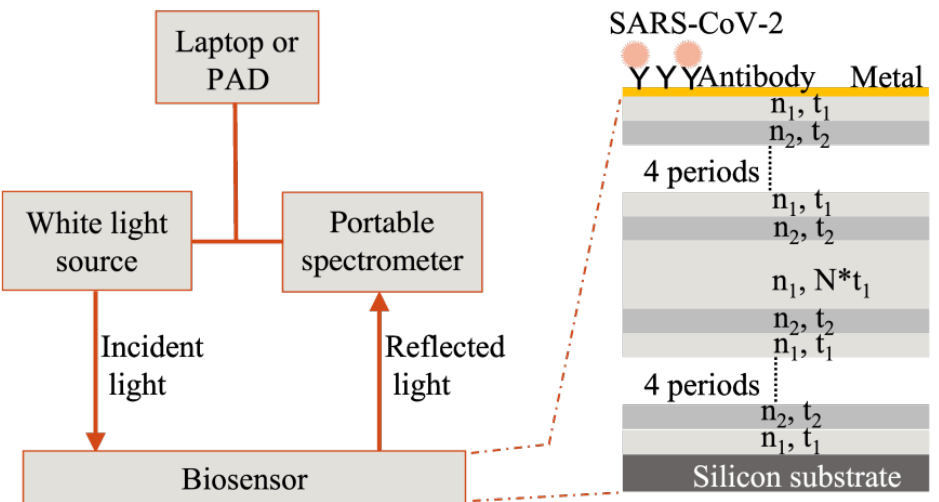
Figure 2. Biosensor and its portable detection system. Two different porous silicon layers construct the resonant microcavity, with an optical refractive index and thickness of n 1 , t 1, and n 2 , t 2 . There are two 4-periods structures sandwiching a defect layer with thickness N times t 1 . N can be any number except 1. For details, see reference [11]. Due to the nanoporous structures of porous silicon, a conformally deposited metal thin film is also nanoporous, which allows LSPR excitation by incident light.